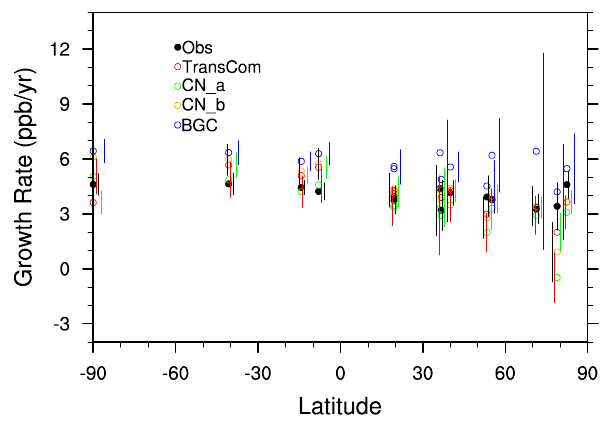
Figure 14. Atmospheric CH 4 growth rate as a function of latitude in observations, TransCom, CN_a, CN_b, and BGC simulations. 90% confidence intervals are also shown.